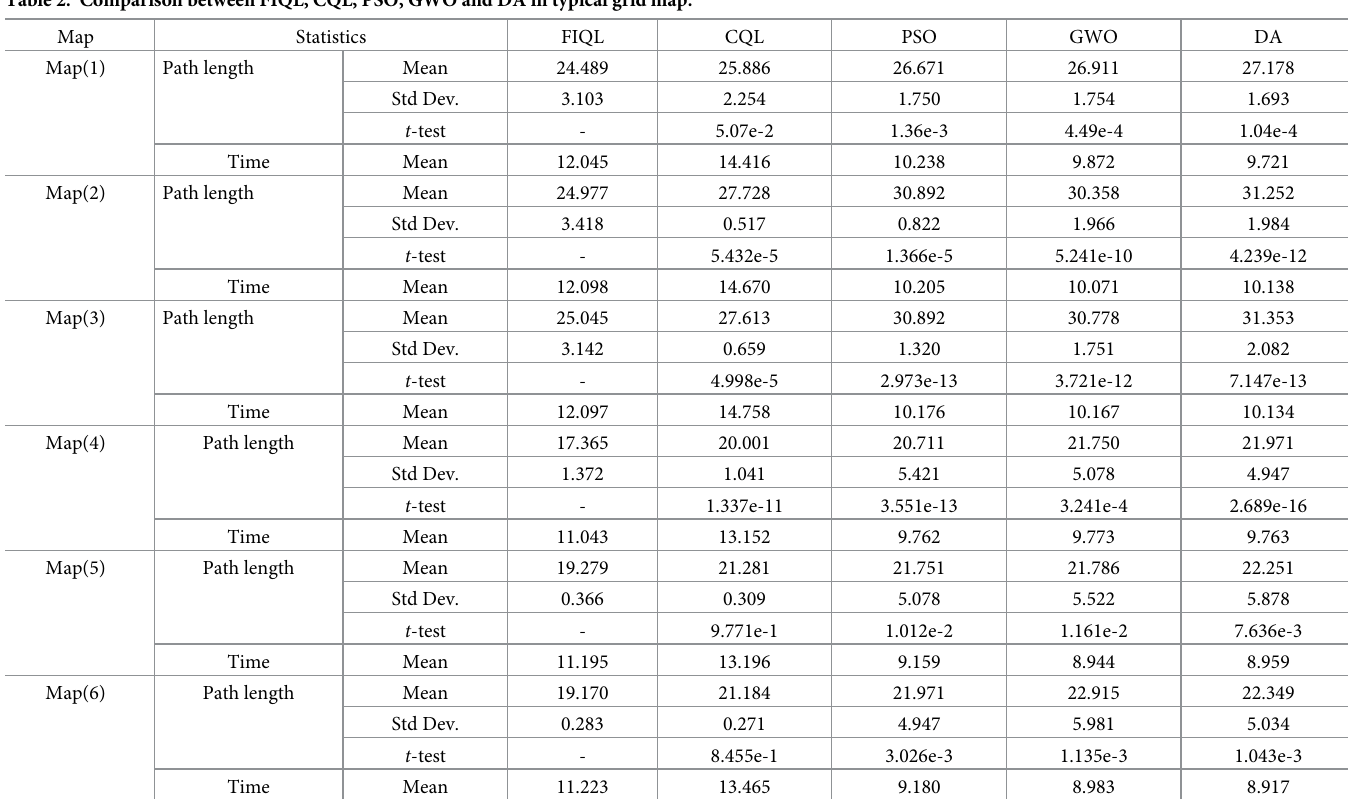
Table 2. Comparison between FIQL, CQL, PSO, GWO and DA in typical grid